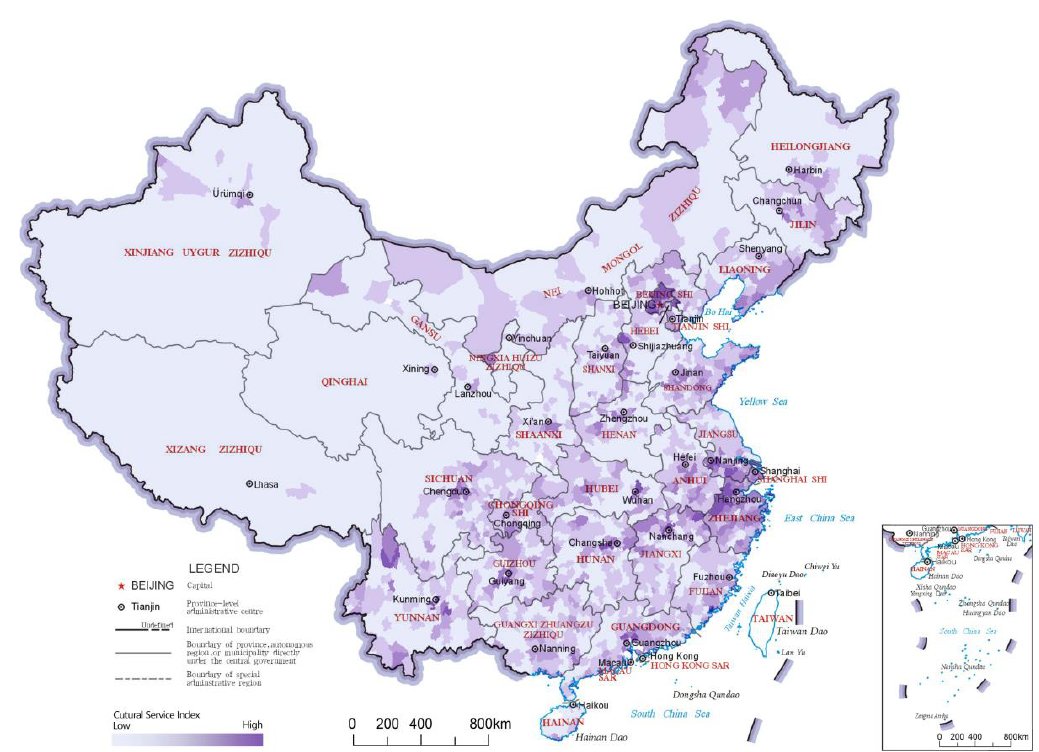
Figure 7. Distribution map of cultural service indices of the county-level regions in China.